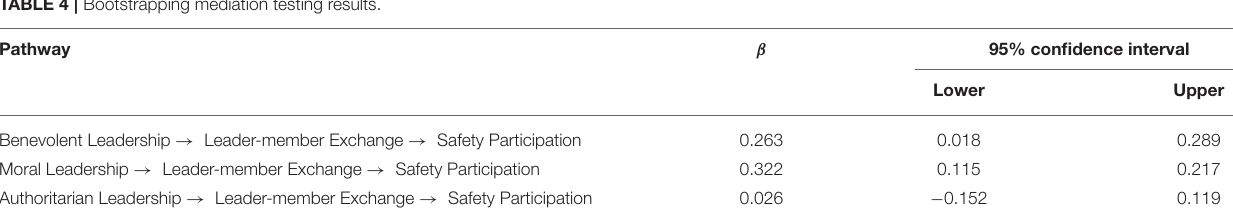
TABLE 4 | Bootstrapping mediation testing